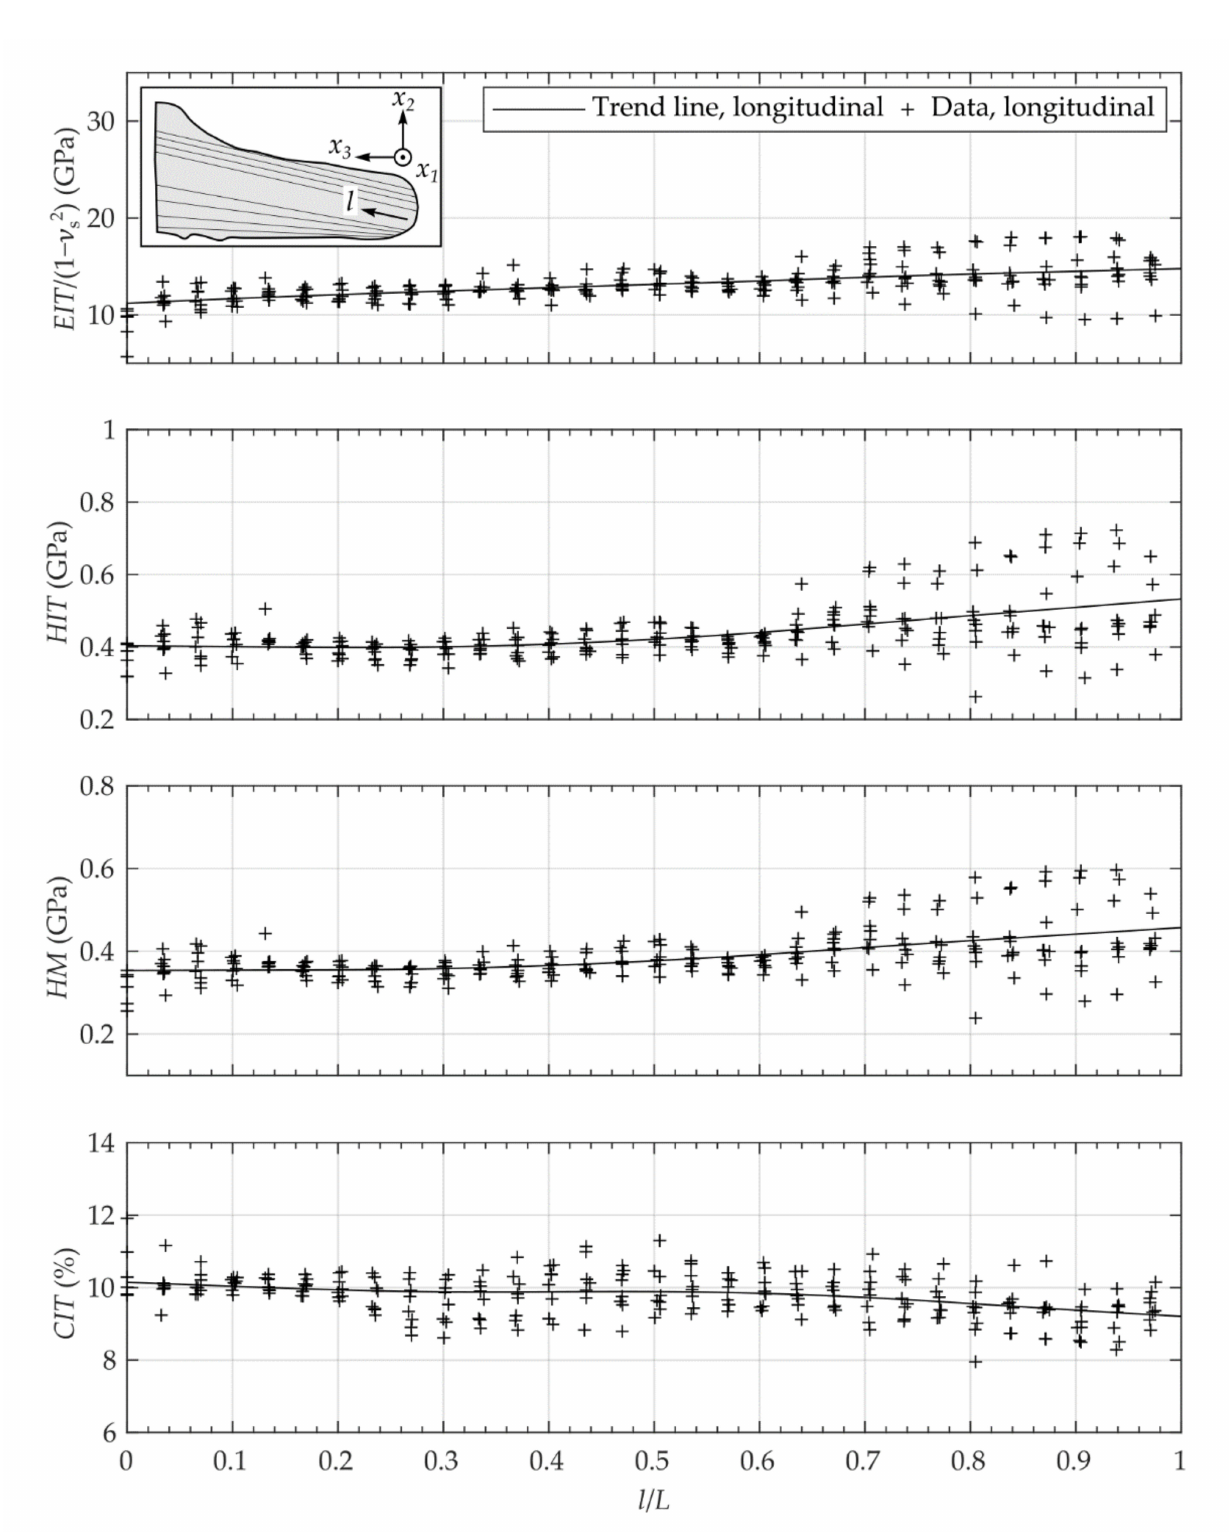
Figure 7. Micro-mechanical properties of the longitudinal segment evaluated at cutting lines (8